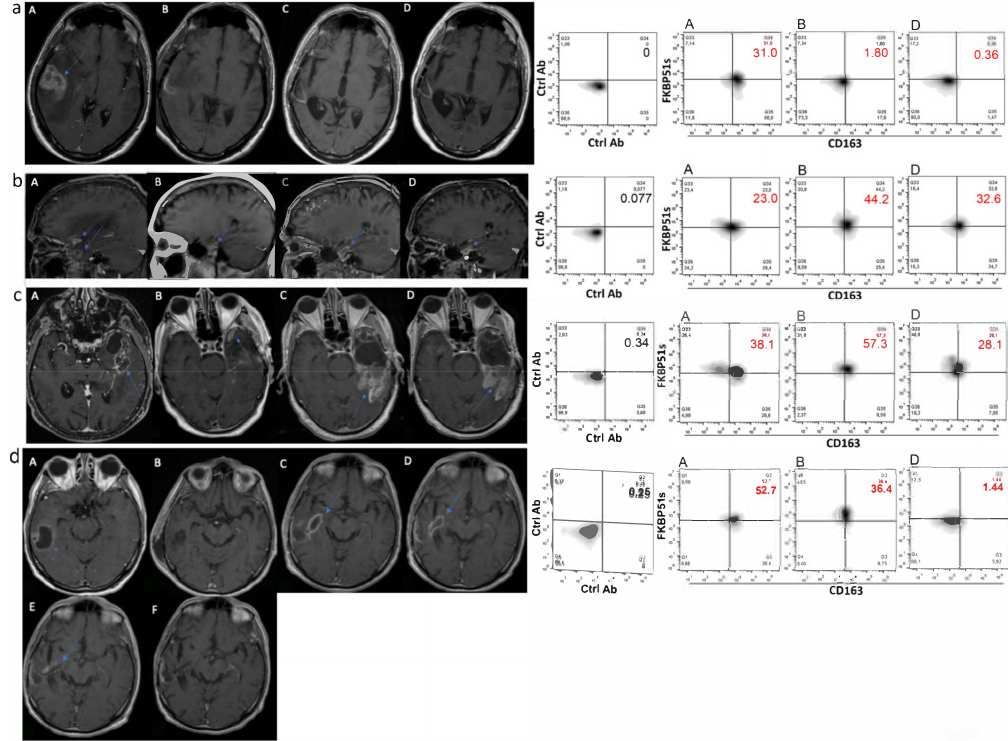
Figure 4. MRI and CD163/FKBP51s+ monocytes on follow-up. Axial T1 images after contrast medium administration: the glioblastoma before surgery in A, the immediate post-operative image in B, post-radio-chemotherapy in C, and post- adjuvant temozolomide (TMZ) in D. On the right, correspondent flow cytometry of CD163/FKBP51s+ monocytes. ( a ) The glioblastoma before surgery in the right temporal lobe. The immediate post-operative image shows a macroscopically complete exeresis of the tumor. Images C and D show no disease progression. ( b ) The glioblastoma before surgery in the right temporal lobe. The immediate post-operative image shows a residual tumor. Images C and D show the stability of the residual tumor. ( c ) The glioblastoma before surgery in the left temporal lobe. The immediate post-operative image shows a residual tumor. Image C highlights a disease progression, which tends to be stable in subsequent D control. ( d ) The glioblastoma before surgery in the right temporal lobe. The post-operative image shows a macroscopically complete exeresis of the tumor. C and D images show a thick impregnation area along the deepest portion of the surgical cave suspected for disease progression, which tended to regress in subsequent controls (E,